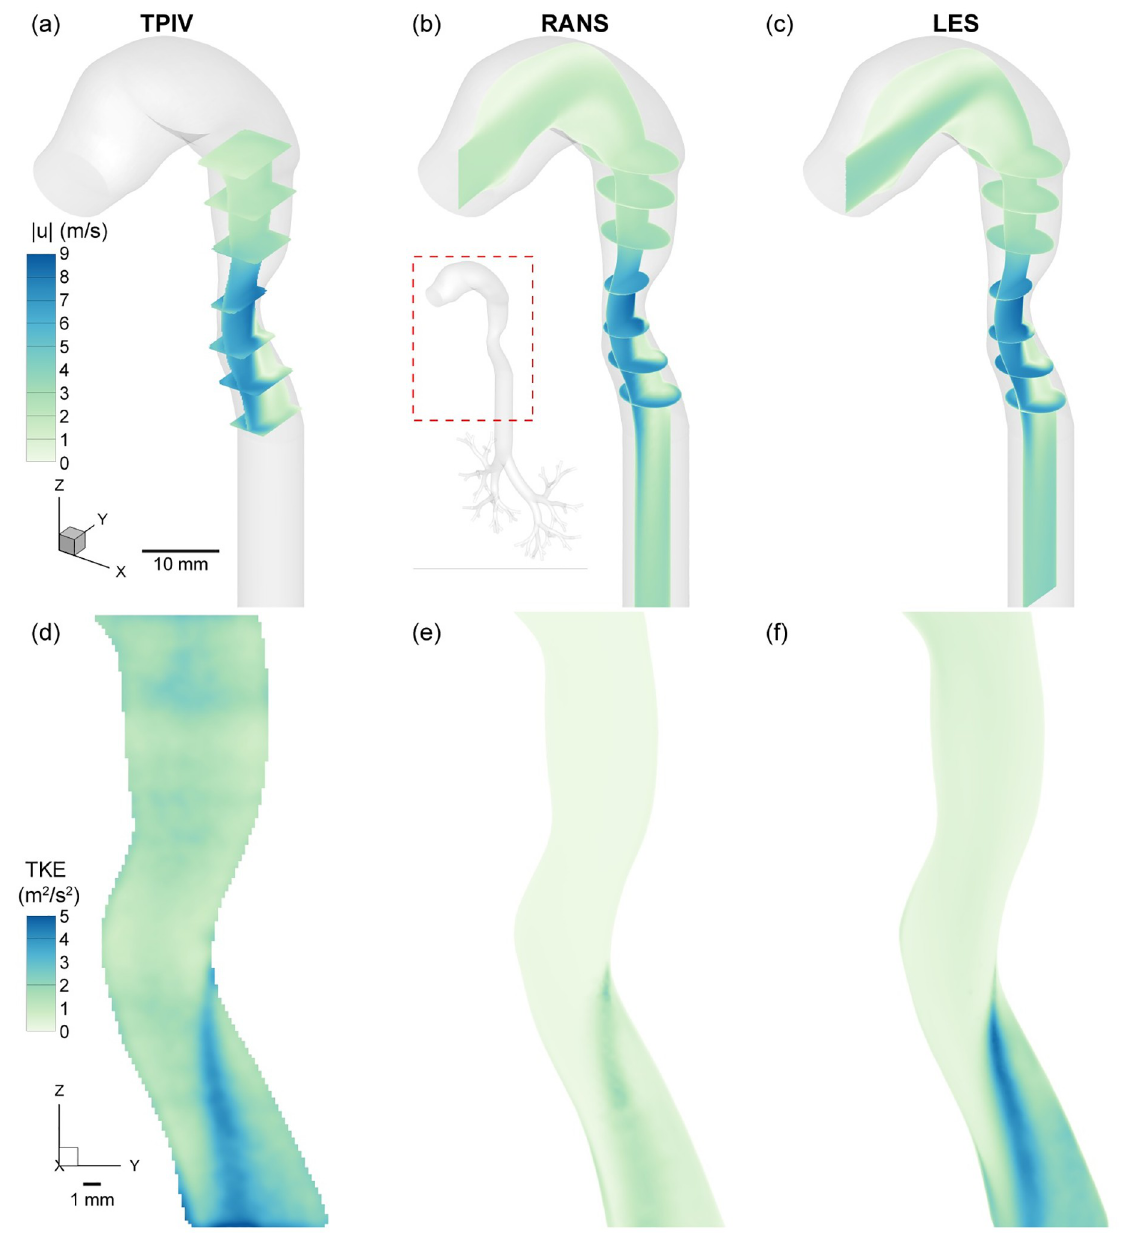
Fig 3. Comparison of flow characteristics between tomographic PIV (TPIV), Reynolds Averaged Navier Stokes (RANS) and Large Eddy Simulation (LES) for the high flowrate case (Re = 7’000). Top row: Velocity magnitude contours along the mid-sagittal plane shown along with several orthogonal transverse planes to illustrate 3D characteristics of the flow. Bottom row: Turbulent kinetic energy (TKE) contours are plotted on the mid-sagittal plane. Results are generally in good agreement with strong similarity but derivative TKE values reveal more subtle differences. Specifically, RANS underestimates the peak TKE values near the jet’s wake while the TPIV data introduce background noise.